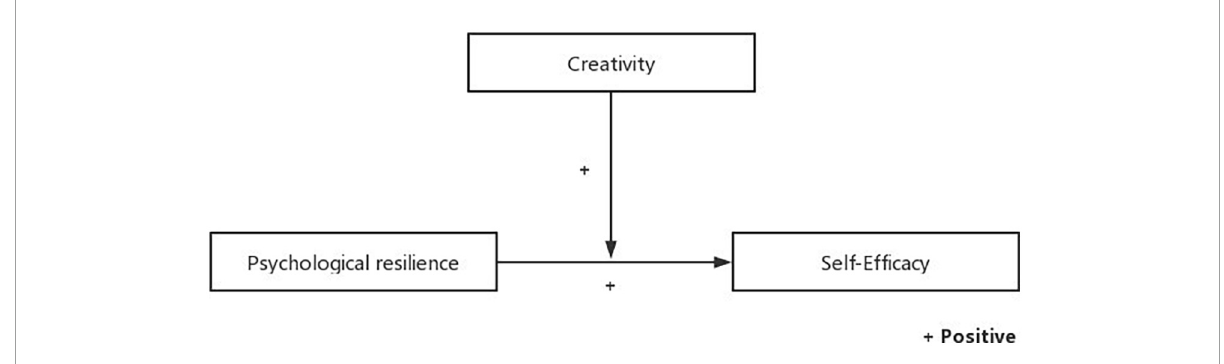
FIGURE1 Conceptual model of the hypotheses.